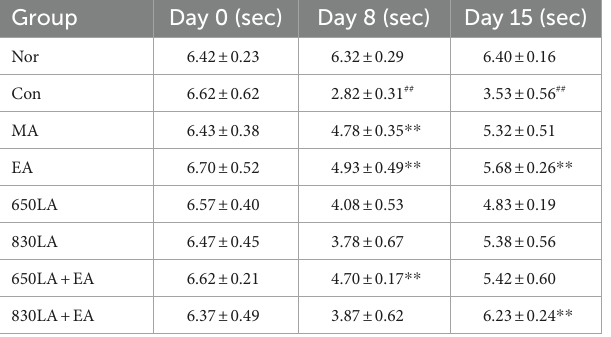
TABLE 3 Changes in von Frey reaction times in rats with paclitaxel- induced allodynia according to type of acupuncture treatment. Group